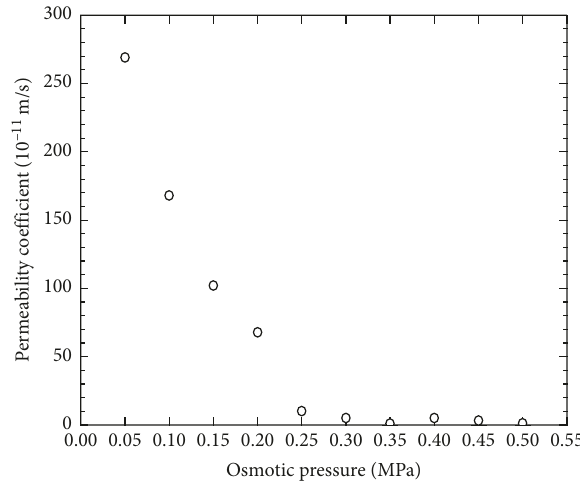
Figure 6: GCLs permeability coefficient under different osmotic